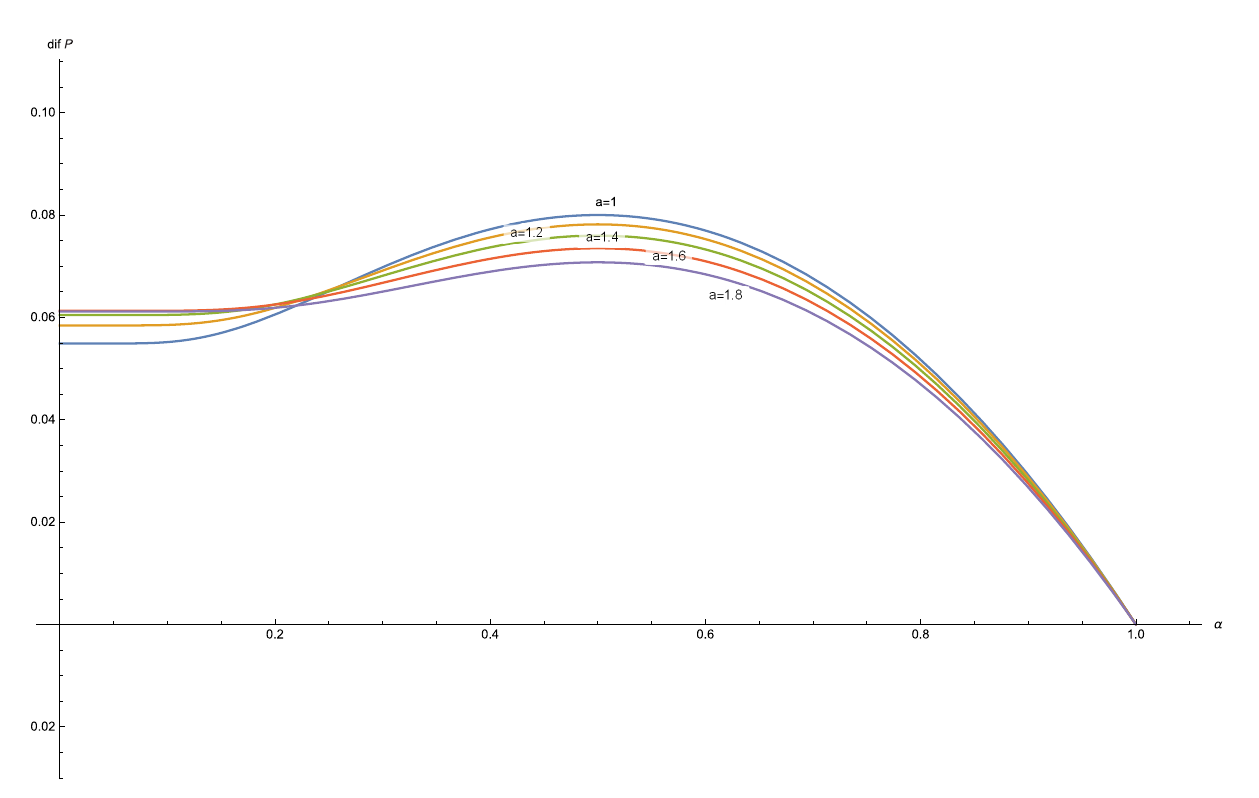
Fig 6. dif ( P ) for a = 1, 1.2, 1.4, 1.6, 1.8 in the Poisson-exponential case with δ = 0.03, λ = 1, γ = 0.6.